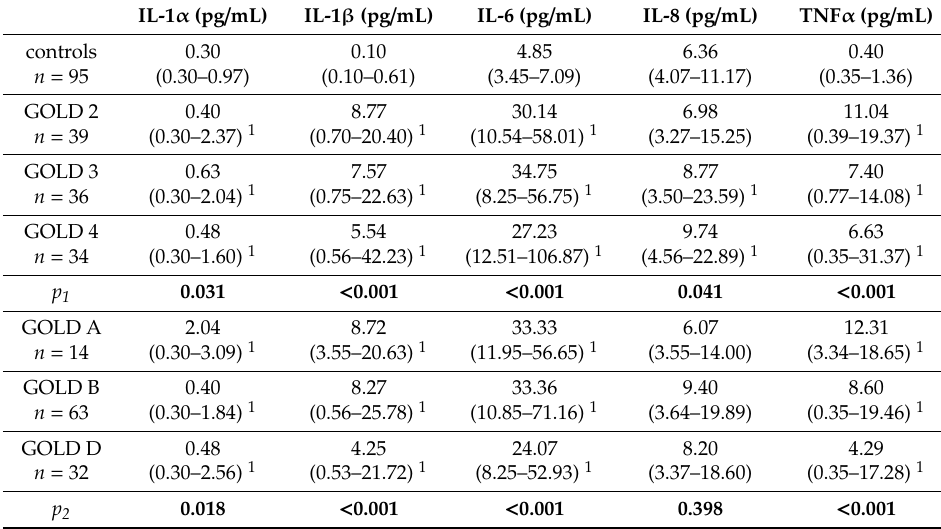
Table 2. Concentration of cytokines in healthy participants and COPD patients regarding the severity of airflow obstruction assessed by FEV 1 (GOLD 2-4 stages) and the severity of symptoms and exacerbation history (GOLD A-D